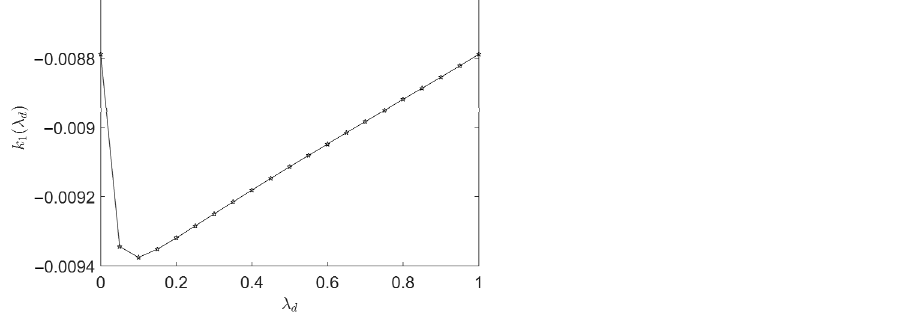
Figure 3. The dependence k 1 ( λ d ) for the reaching-law-based sliding mode controller (RSMC) stability analysis case.